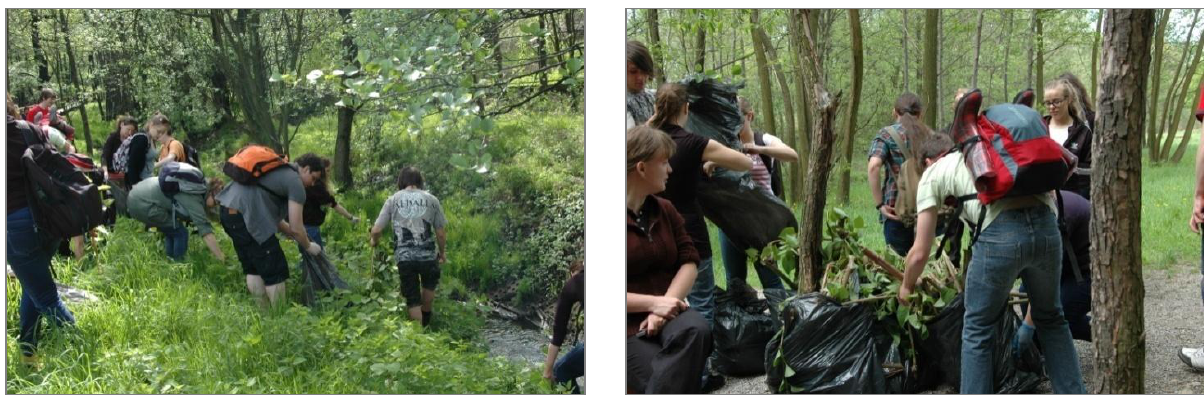
Fig. 5. Removal of Reynoutria japonica shoots (A) and securing the collected biomass for utilization(B) by students from the Faculty of Biology and Environmental Protection of the University of Silesia, as part of field work in the Ślepiotka valley ( K. Bzdęga , 2013)